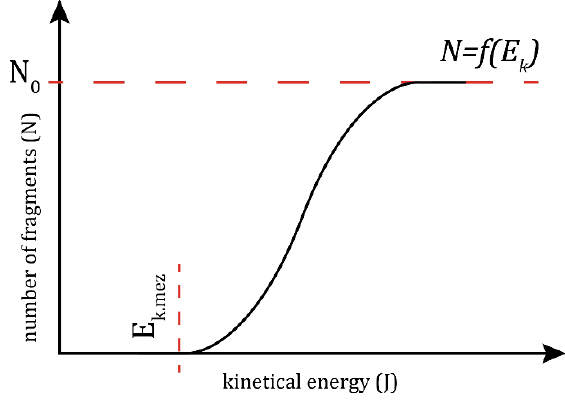
Figure 1. The relationship between the number of fragments ( N ) and the projectile kinetical energy ( E k ) after the impact stage.